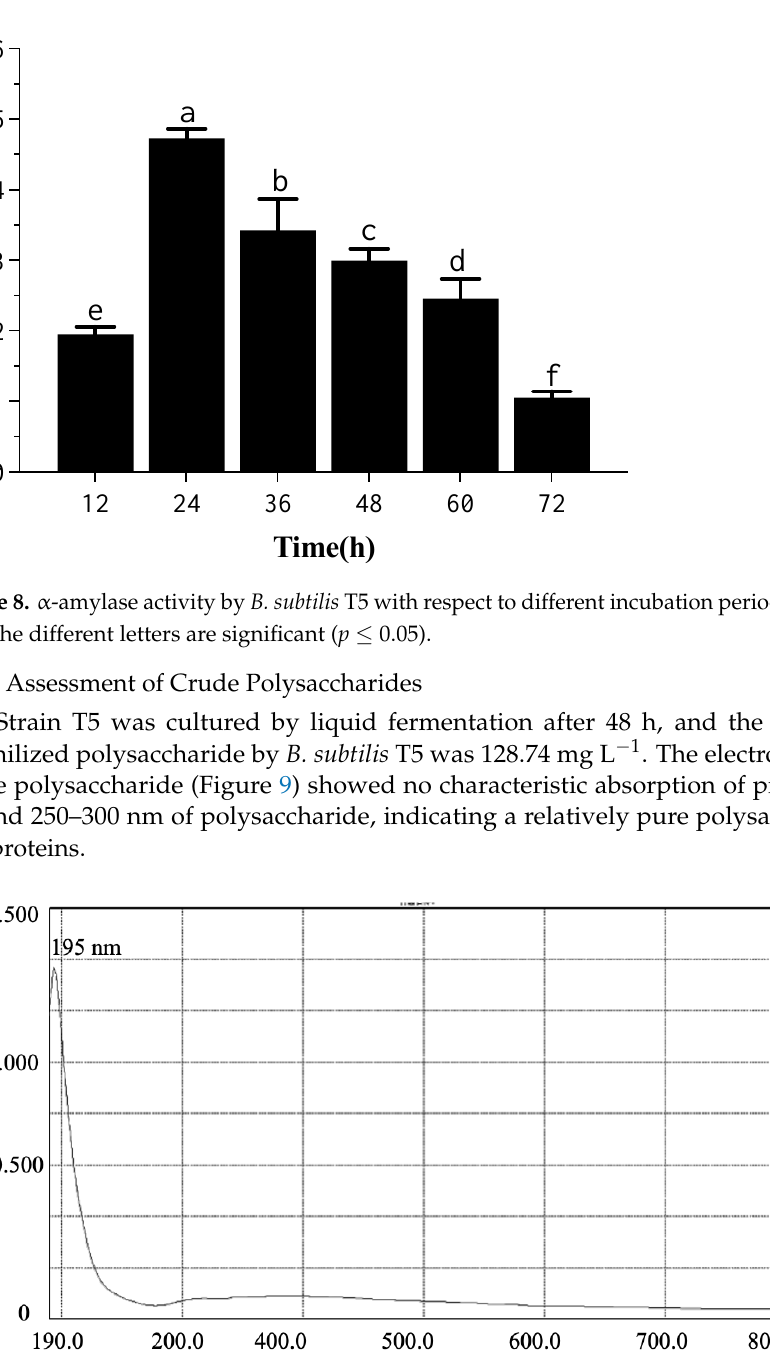
Figure 10. Effect of selenite on α -amylase activity by B. subtilis T5 with respect to different incuba- tion periods; mean values with the different letters are significant ( p ≤ 0.05). 3.6.2. Assessment of the Selenium Polysaccharides in the Presence of 5 mM Selenite Biosynthesis of selenium-enriched polysaccharide was produced by liquid fermen- tation of selenium-tolerant strain T5 containing the optimal concentration of sodium sel- enite. There were great differences between the treatments in the presence of selenite and the control in the absence of selenite in the average polysaccharide yield and sele- nite content. The total polysaccharide content of strain T5 decreased to 78.15 mg L −1 . The contents of Se in polysaccharides were 2.302 g kg −1 evaluated by HG-AFS. Therefore, 12